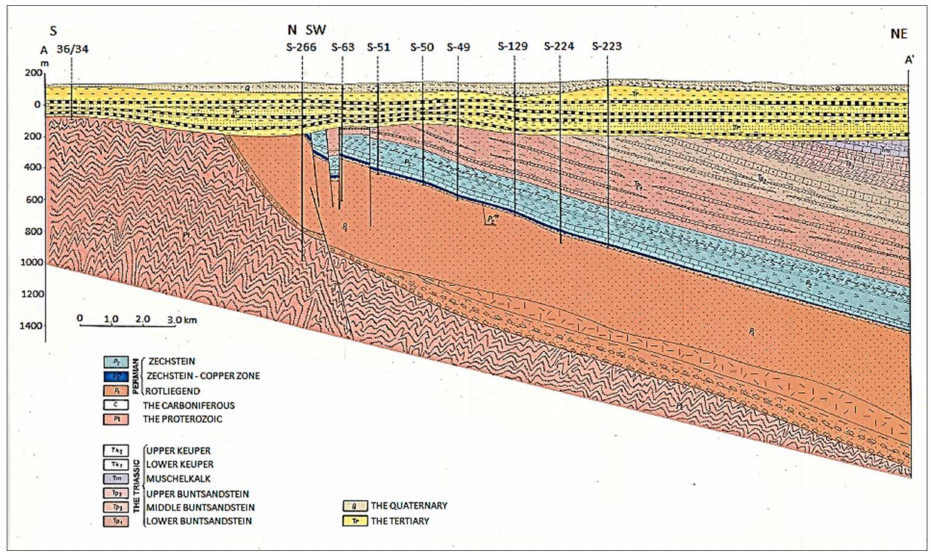
Figure 2. Geological cross-section of the copper ore in the Fore-Sudetic Monocline